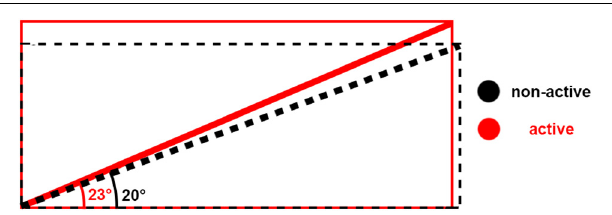
FIGURE 5 | Schematic of architecture changes between non-active (black) and active (red). The schematic shows that when muscle shortens, bulges, and the pennation angle increases, the fiber length may remain at the same